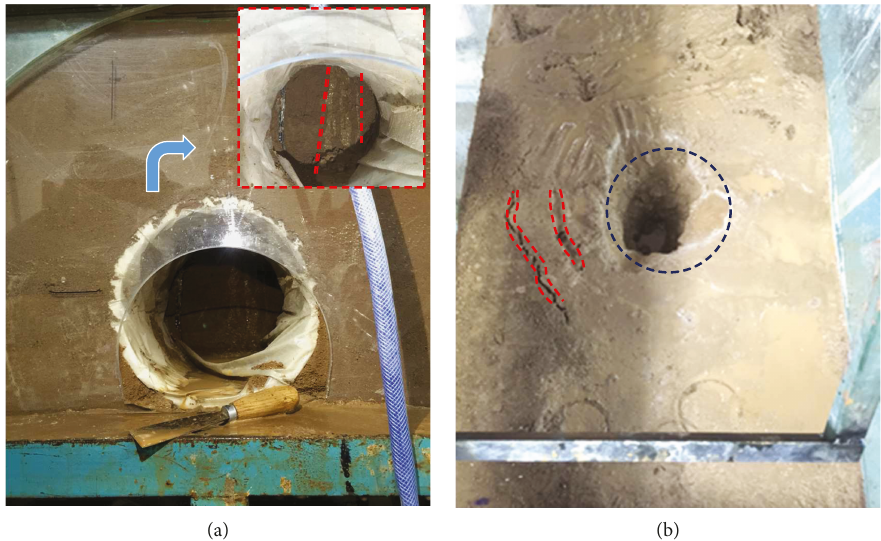
Figure 8: Experiment results. (a) Water gushing in lining; (b) subsidence